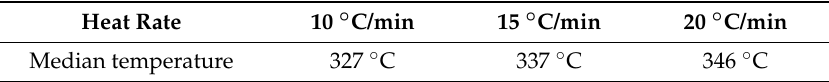
Figure 4. The thermal expansion curves ( a ) and transformed fraction curves ( b ) under 40 MPa tensile stress at a heating rate of 10, 15, 20 °C/min. Table 4. The median temperature under 40 MPa at different heating rates.